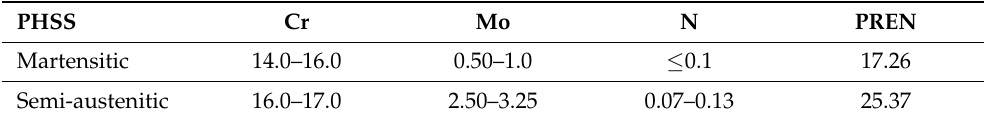
Table 3. Pitting resistance equivalent numbers of the martensitic and semi-austenitic precipitation hardening stainless steel.